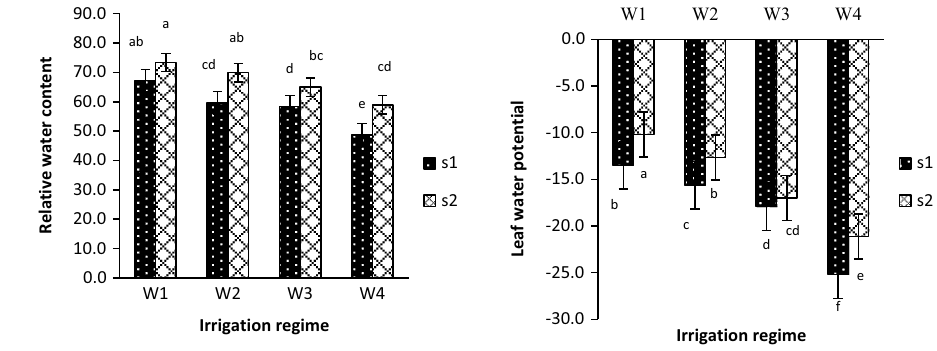
Fig. 6 Interactive effect of vol- canic tuff and irrigation regime on relative water content and leave water potential of olive tree through the 5